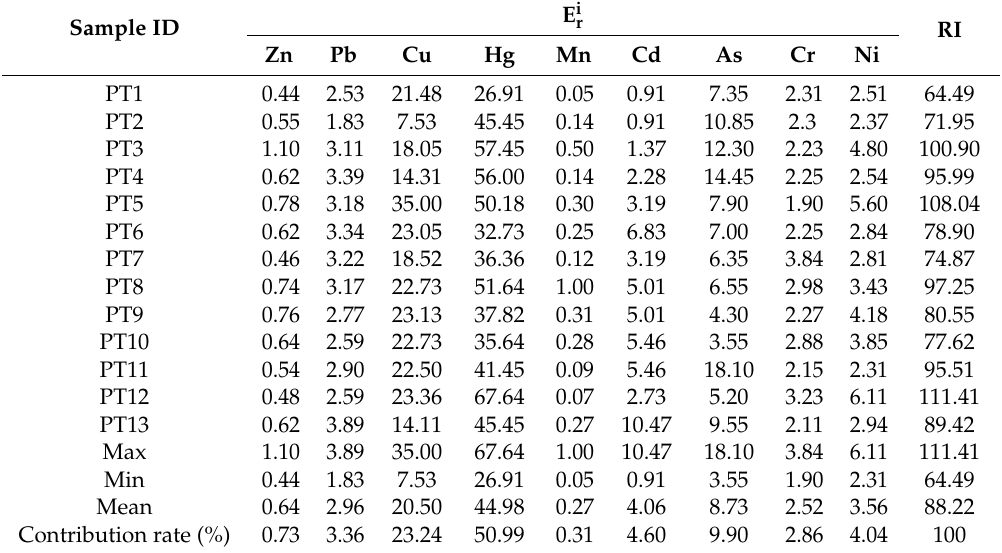
Table 2. Minimum, maximum, and mean of single ecological risk (E i r ) and potential ecological